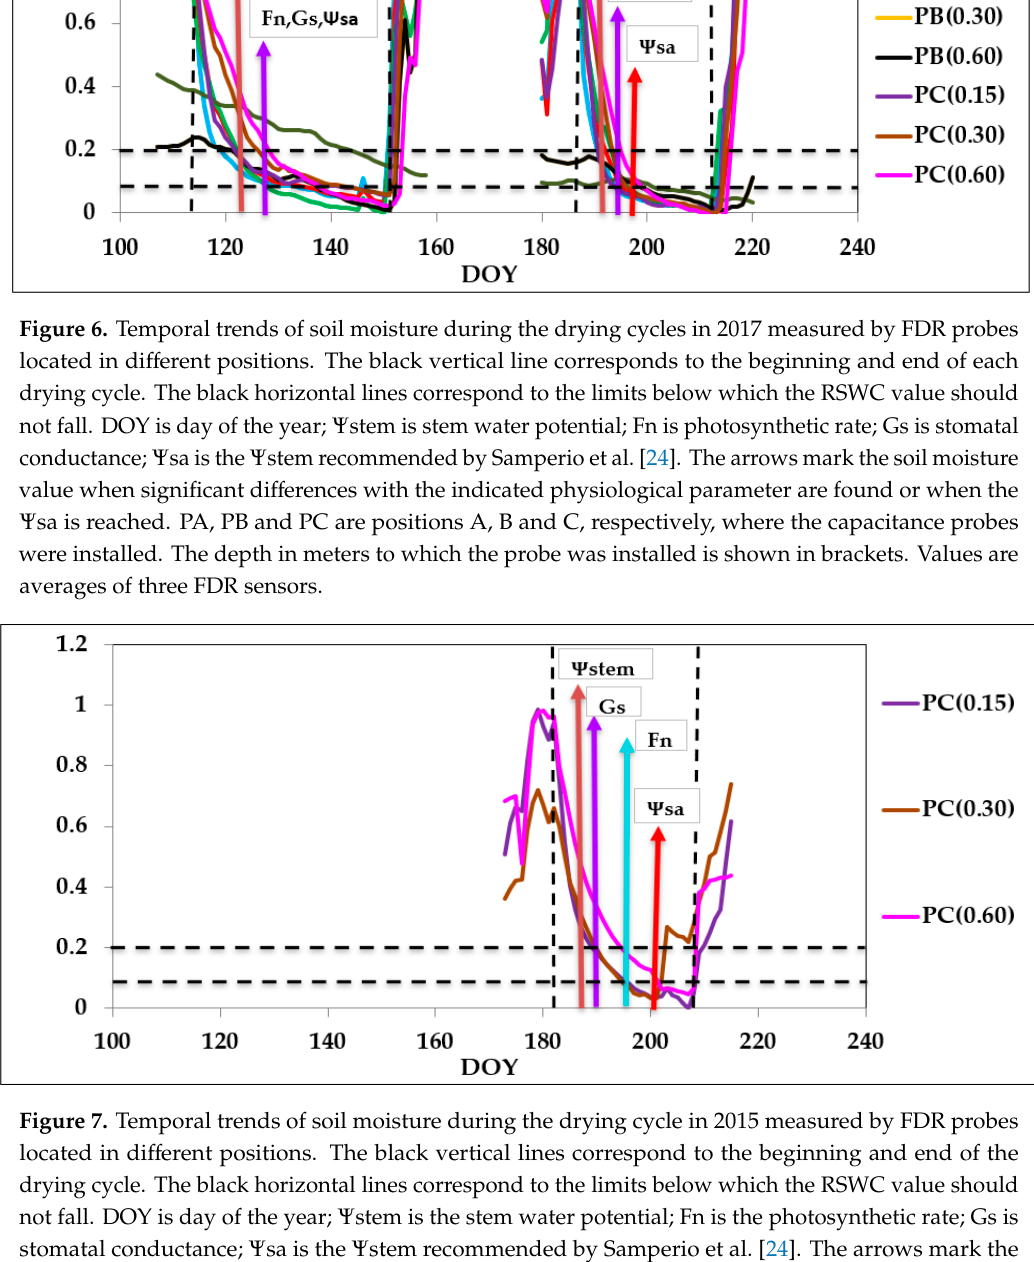
Figure 7. Temporal trends of soil moisture during the drying cycle in 2015 measured by FDR probes located in different positions. The black vertical lines correspond to the beginning and end of the drying cycle. The black horizontal lines correspond to the limits below which the RSWC value should not fall. DOY is day of the year; Ѱ stem is the stem water potential; Fn is the photosynthetic rate; Gs is stomatal conductance; Ѱ sa is the Ѱ stem recommended by Samperio et al. [24]. The arrows mark the soil moisture value when significant differences with the indicated physiological parameter are found or when the Ѱ sa is reached. PC is position C where the capacitance probes were installed. The depth in meters to which the probe was installed is shown in brackets. Values are averages of three FDR sensors.